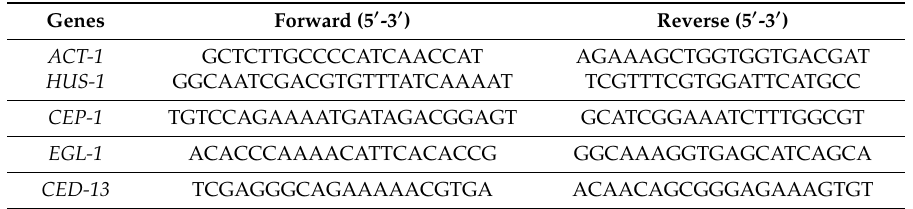
Table 1. Primer sequence listing of